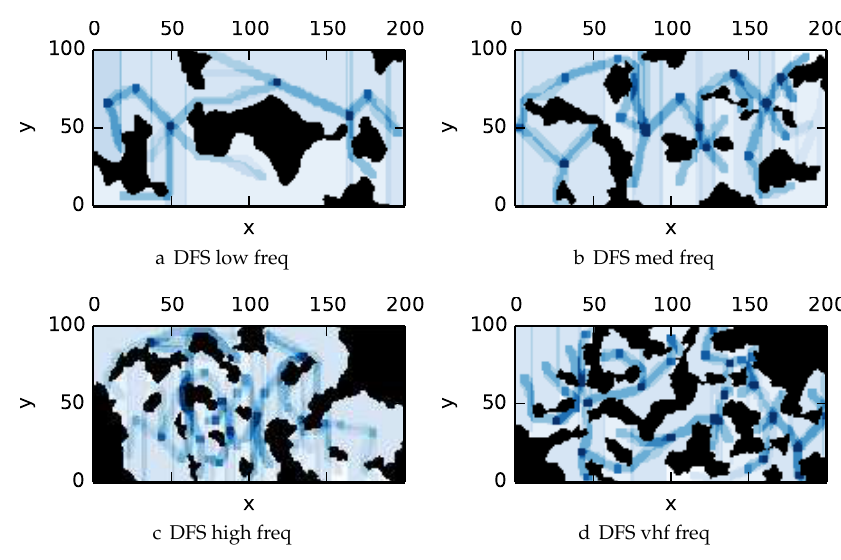
Figure 13. Multipass coverage plans in environments with uniform information for the DFS coverage planner algorithm.